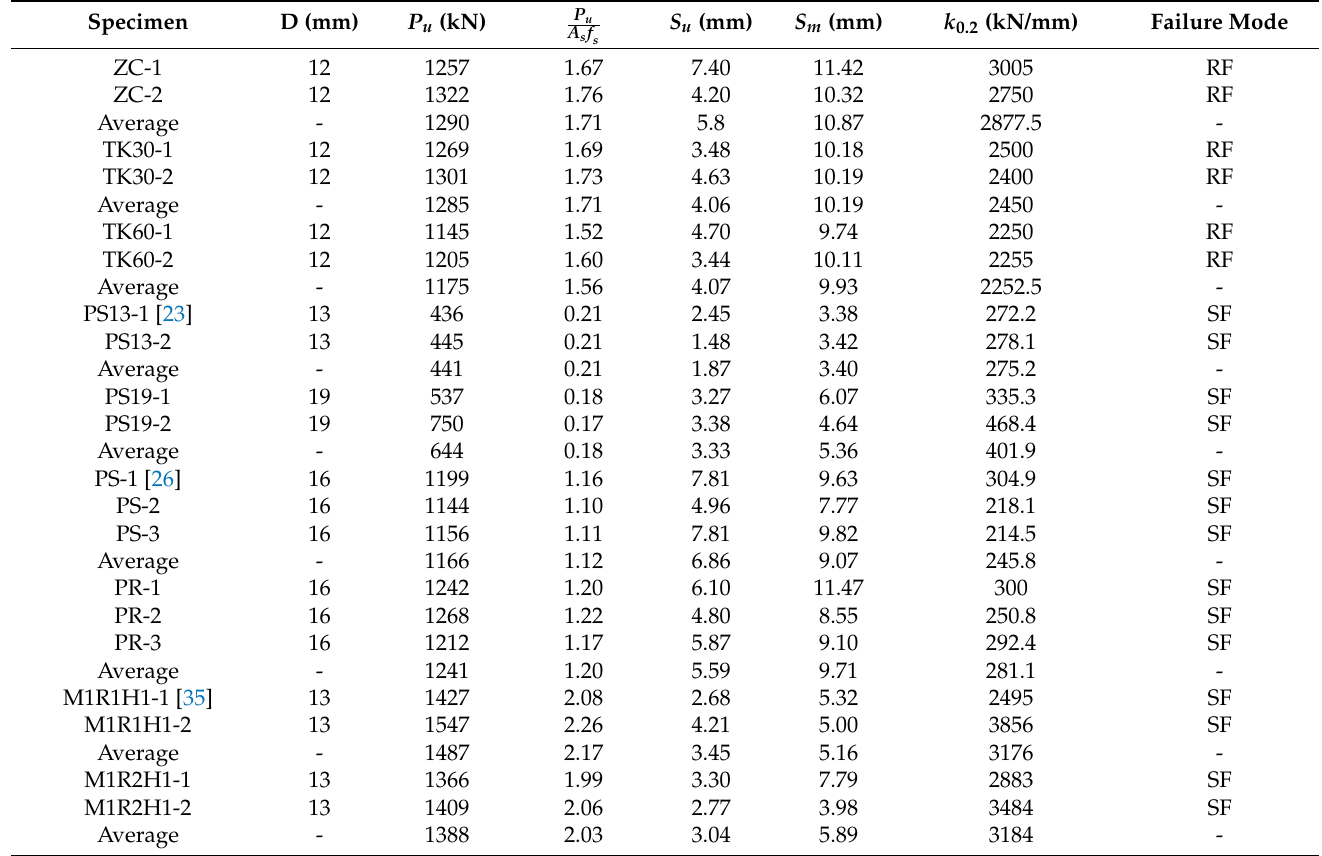
Table 7. Comparison of the shear resistance of stud connectors in different